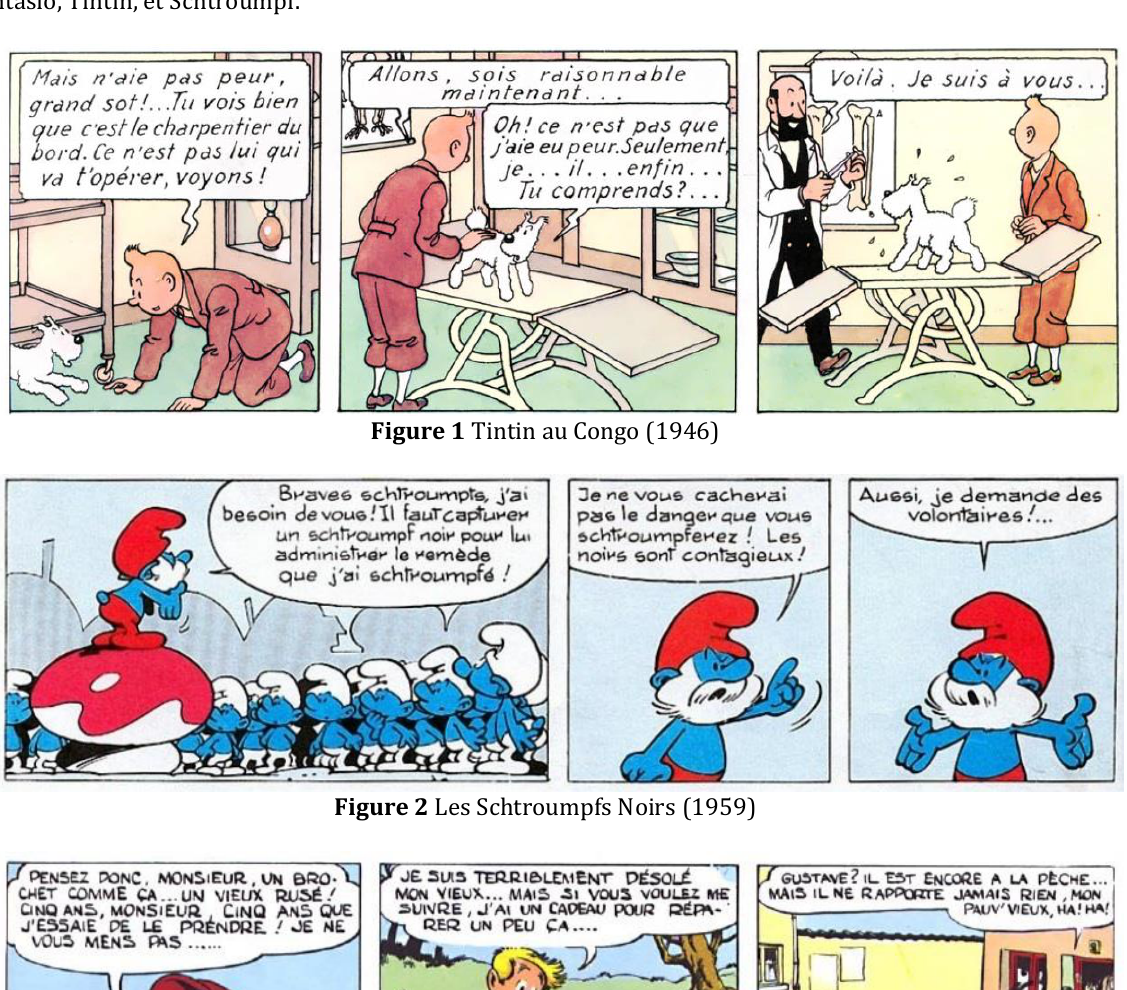
Figure 2 Les Schtroumpfs Noirs (1959)